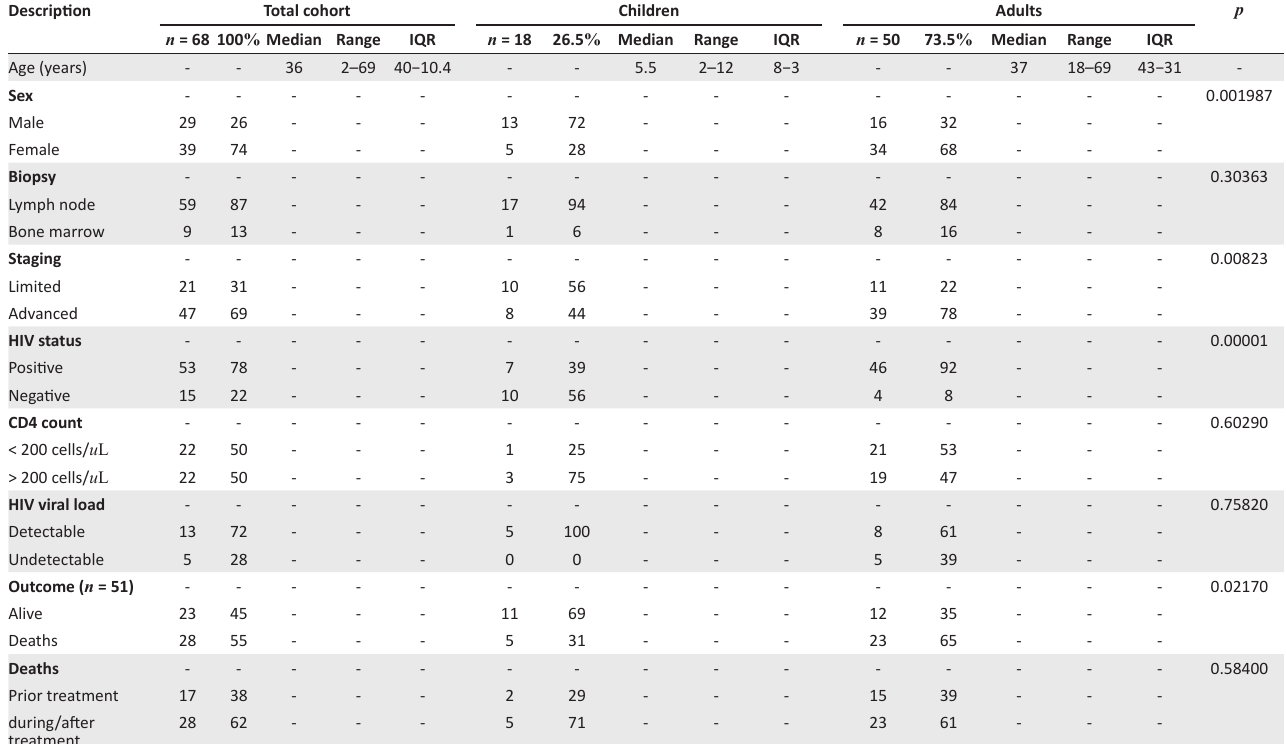
TABLE 1: Epidemiological characteristics. Description